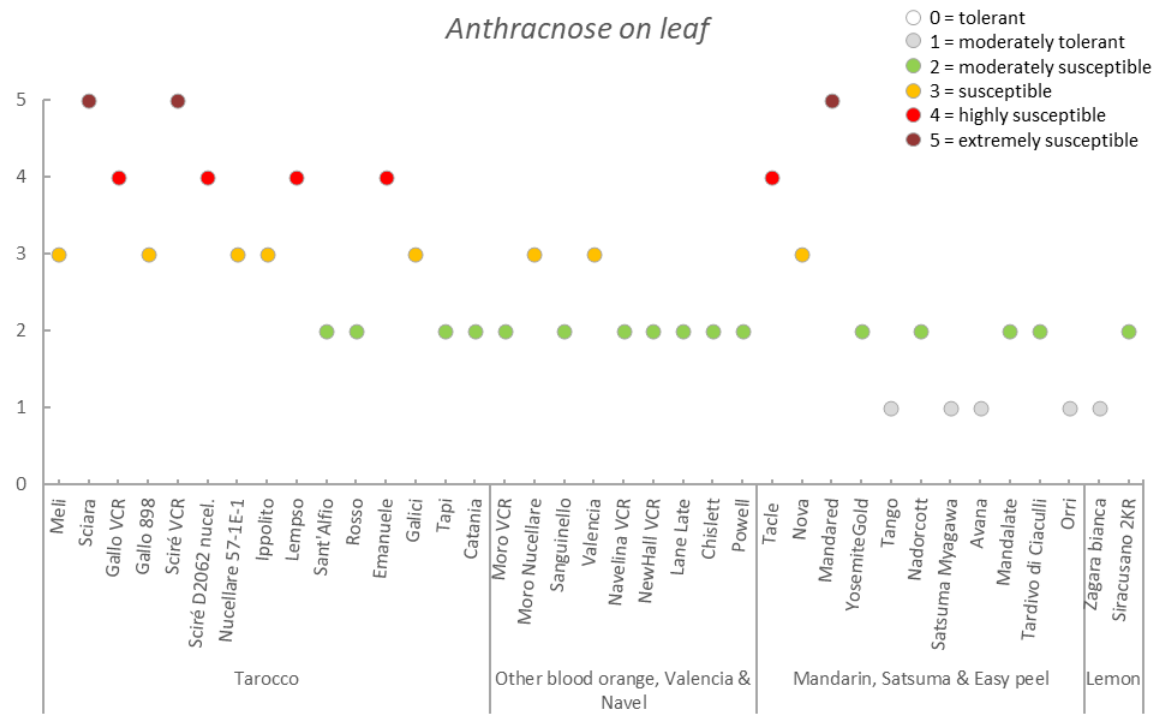
Figure 11. Maximum potential infection risk of anthracnose on leaf recorded on detected Citrus germplasm. Data obtained from several Sicilian citrus production areas (from 1-to-20) within Citrus groups surveyed for three periods intercepting an eleven-year survey.